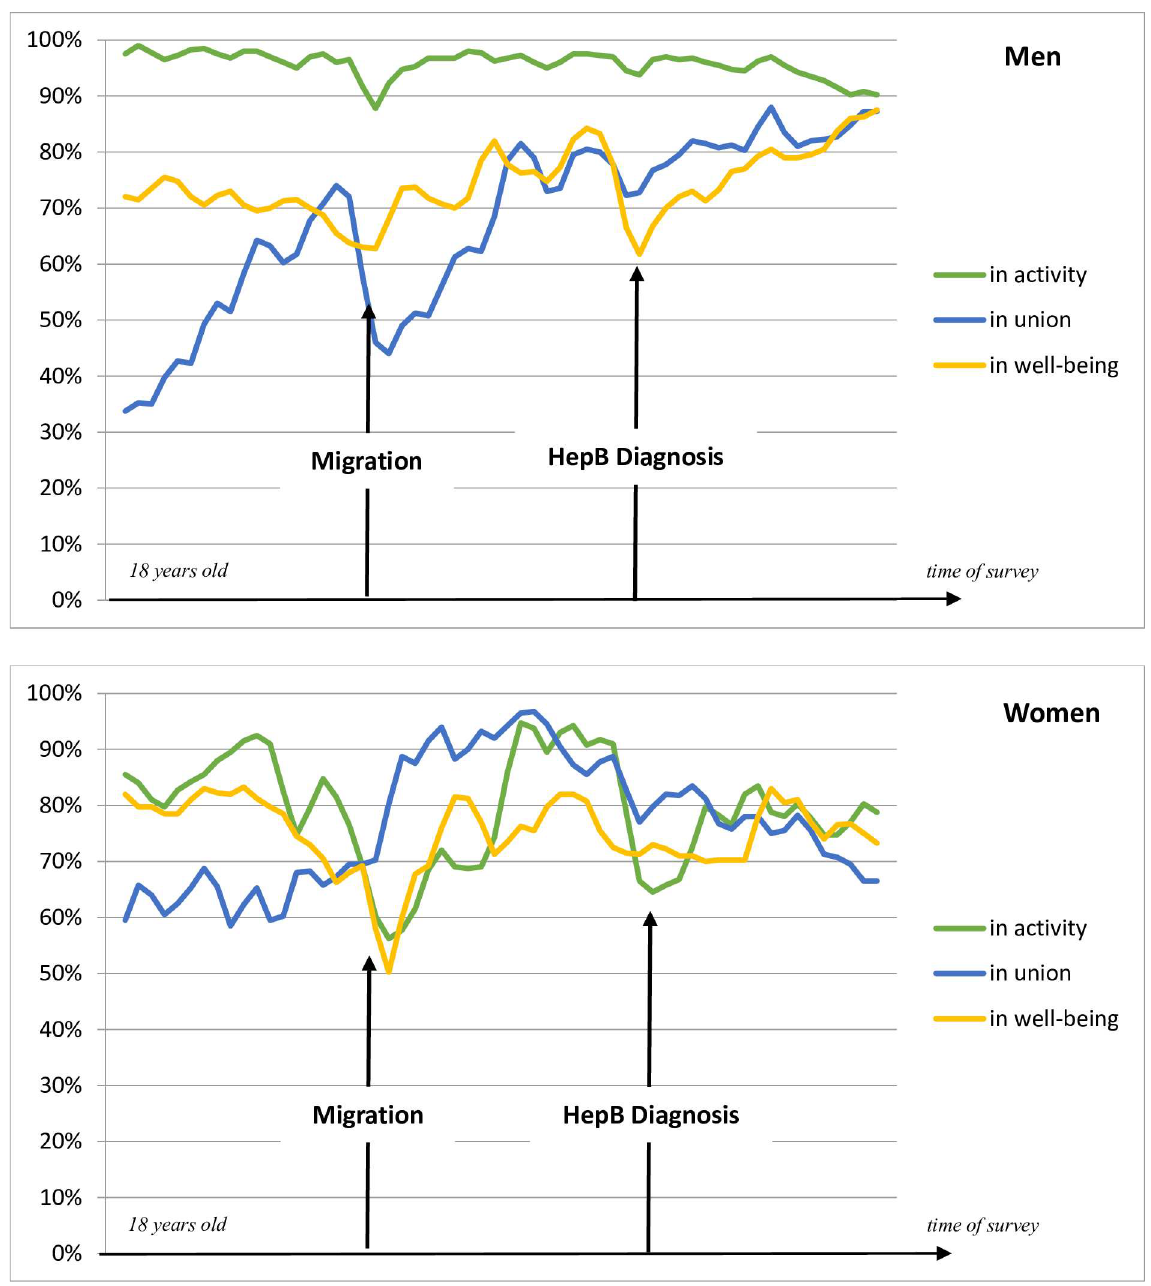
Fig 2. Persons living with chronic Hepatitis B: proportion of men and women in activity, union and well-being in relation to migration and chronic Hepatitis B diagnosis. Time-relative graphs Scope: men (N = 192) and women (N = 66) from Hepatitis B group who have not yet migratedor being diagnosedat 18 years of age, who are observedat least five years after diagnosis,who were diagnosed in France at least one year after arrival. Note: These curves show the proportionof personsin activity, in union and their perceivedwell-beingin relationto two key moments: migrationand diagnosis, for personswho were diagnosed after migration. For more details, please see S2 File and Brou et al. (2007). Source: ANRS Parcours Survey